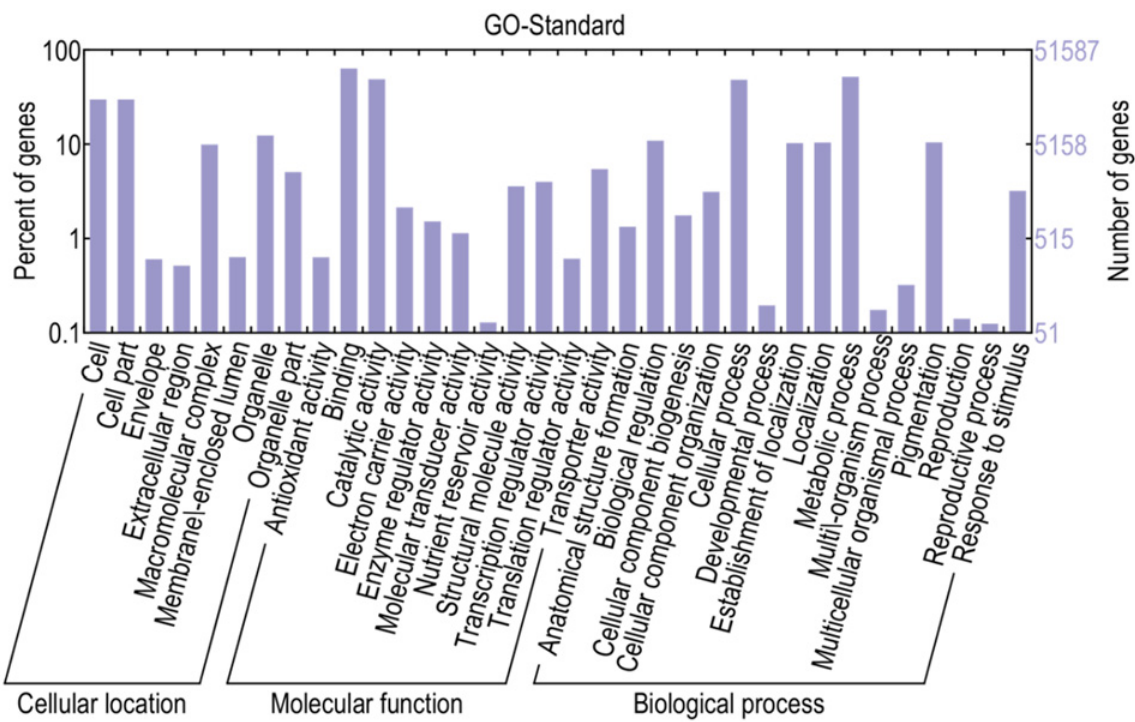
Fig 4. Transcripts Gene Ontology (GO) functional annotation. 51638 transcripts were assigned to GO terms and they were grouped into three main categories with 8 groups in cellular location, 11 groups in molecular function and 15 groups in biological process. The right-hand Y axis stands for the numbers of the genes in groups and the left-hand Y axis represents the percentage of the genes in categories.